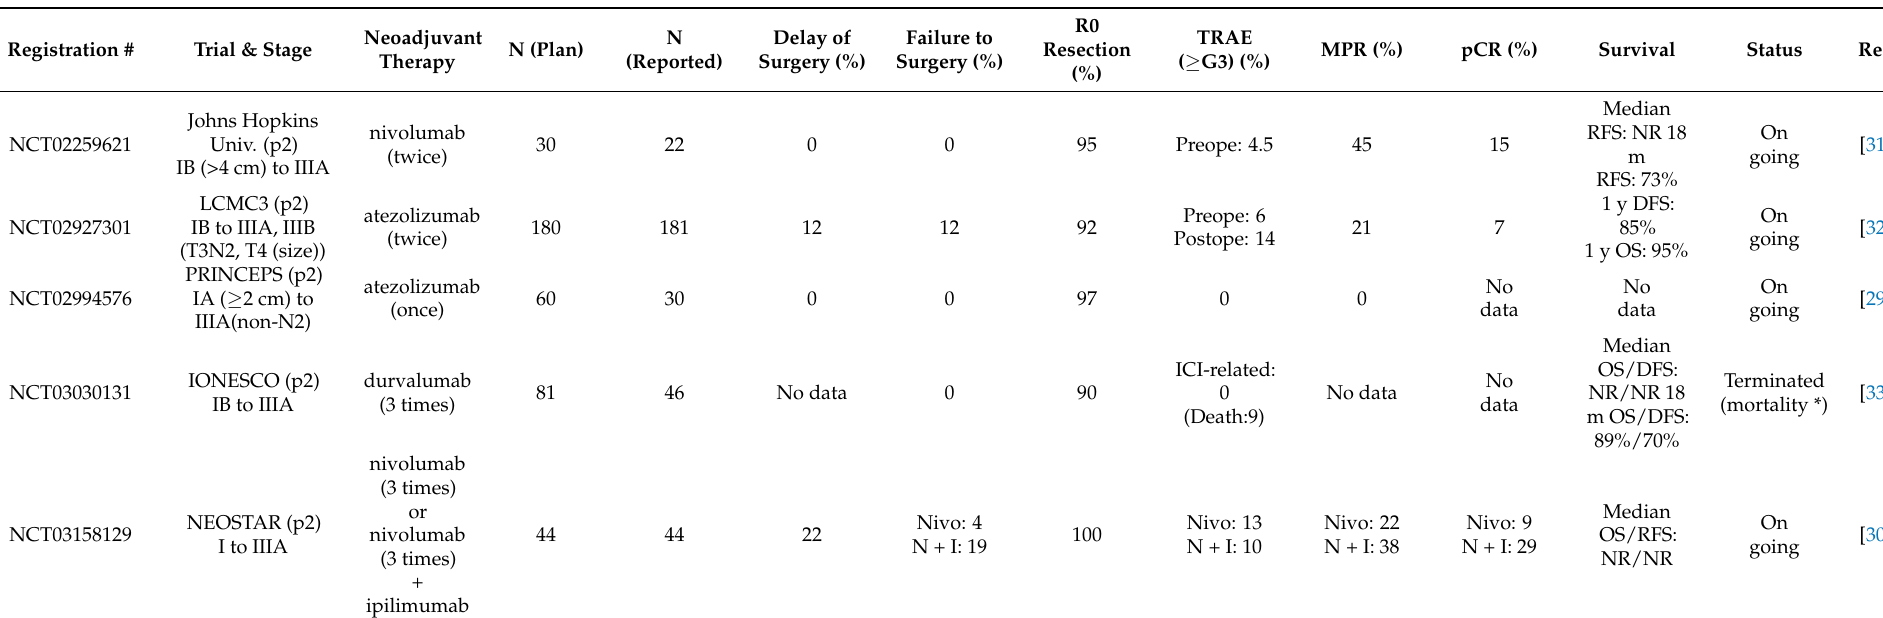
Table 2. Results of clinical trials using neoadjuvant ICI-mono or -dual